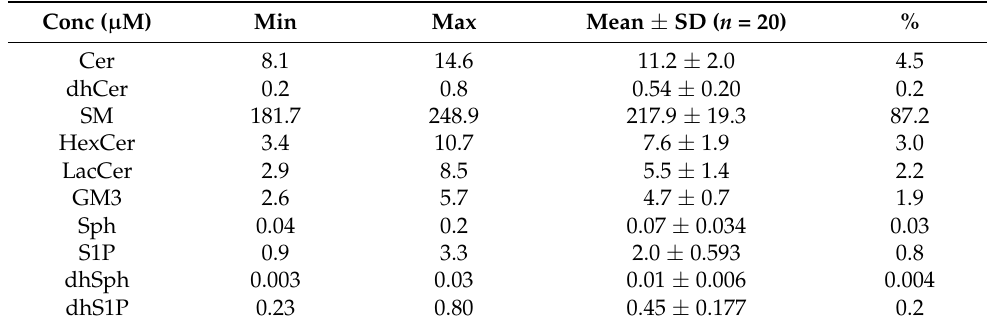
Table 3. Plasma EDTA sphingolipids levels ( µ M) in healthy volunteers ( n = 20) expressed as min–max, mean ± SD and percentage over total sphingolipid content.